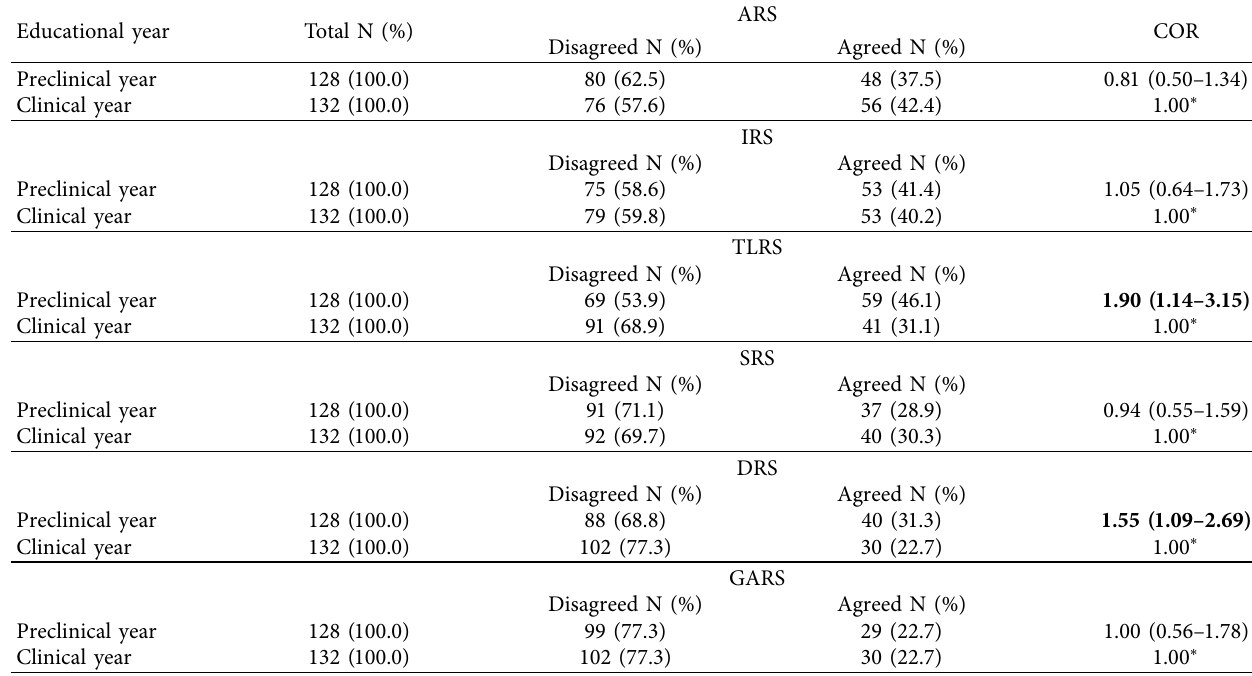
Table 4: Bivariate logistic regression of stressor domain with years of medical education, N � 260, AU, January